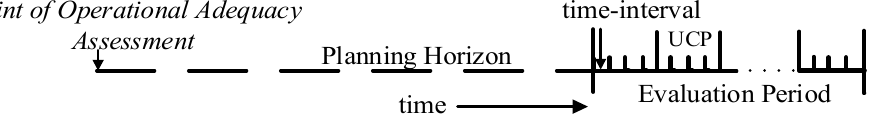
Figure 1. Operational planning horizon and adequacy evaluation period.